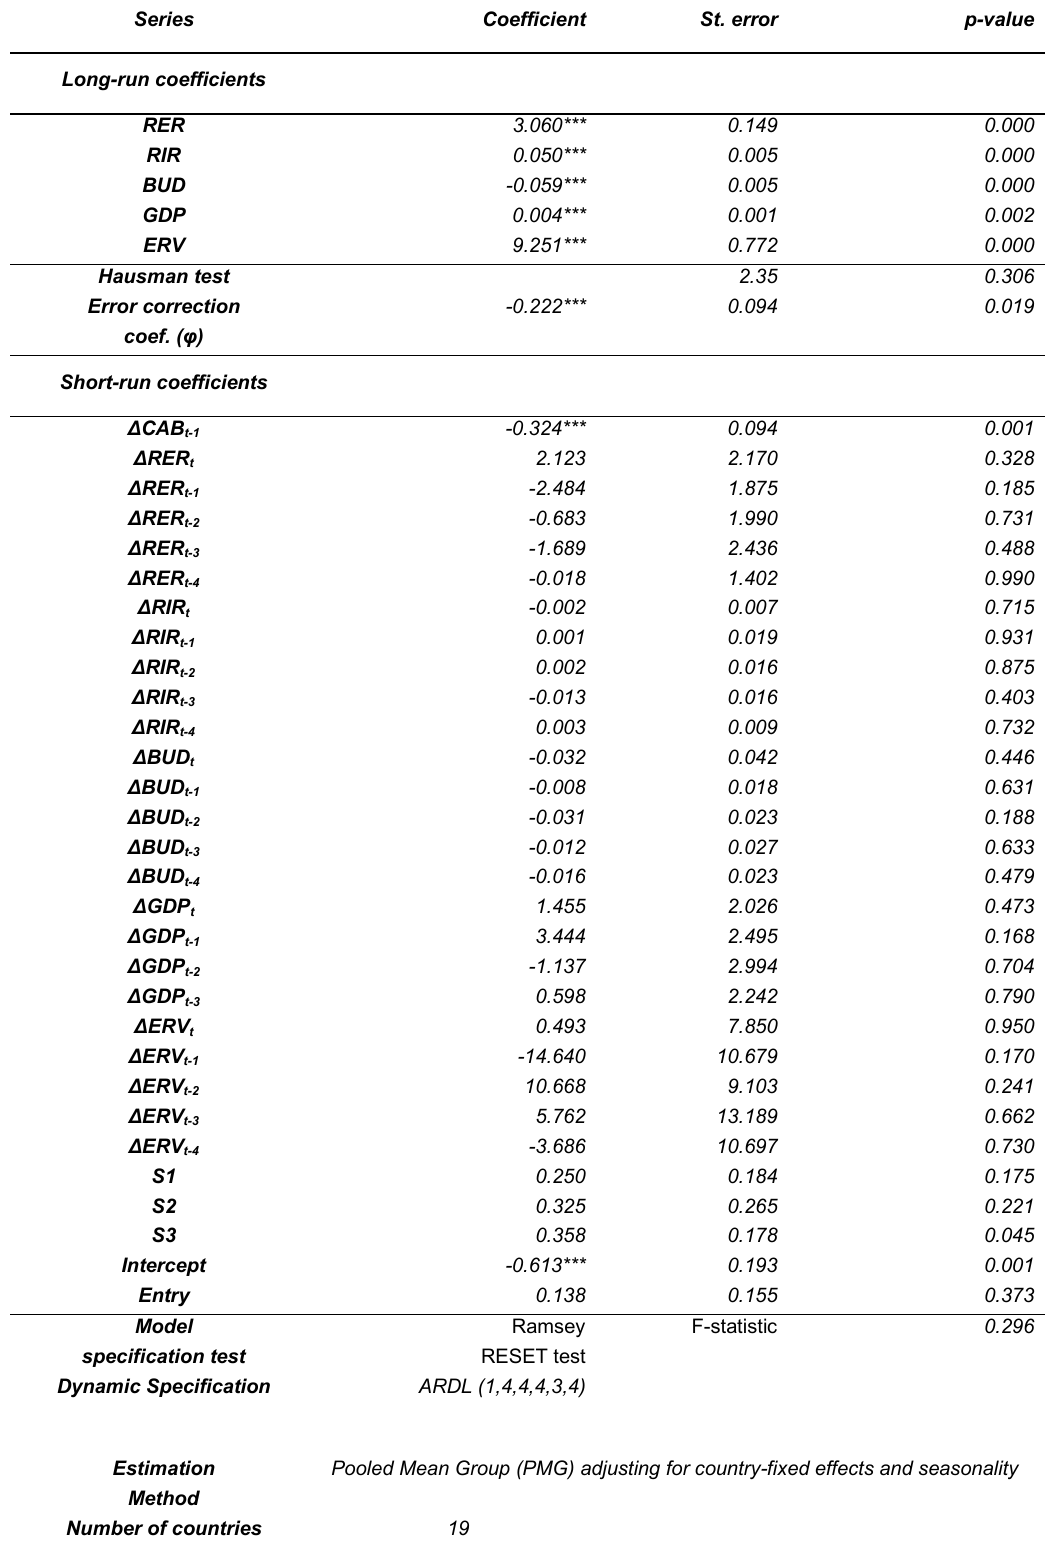
Table 5. Long-run and Short-run coefficients of the Current Account Balance determinants, ARDL